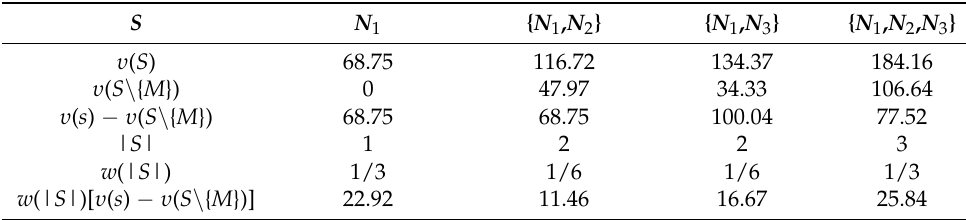
Table 7. Revenue distribution of farmer an under three players alliance.